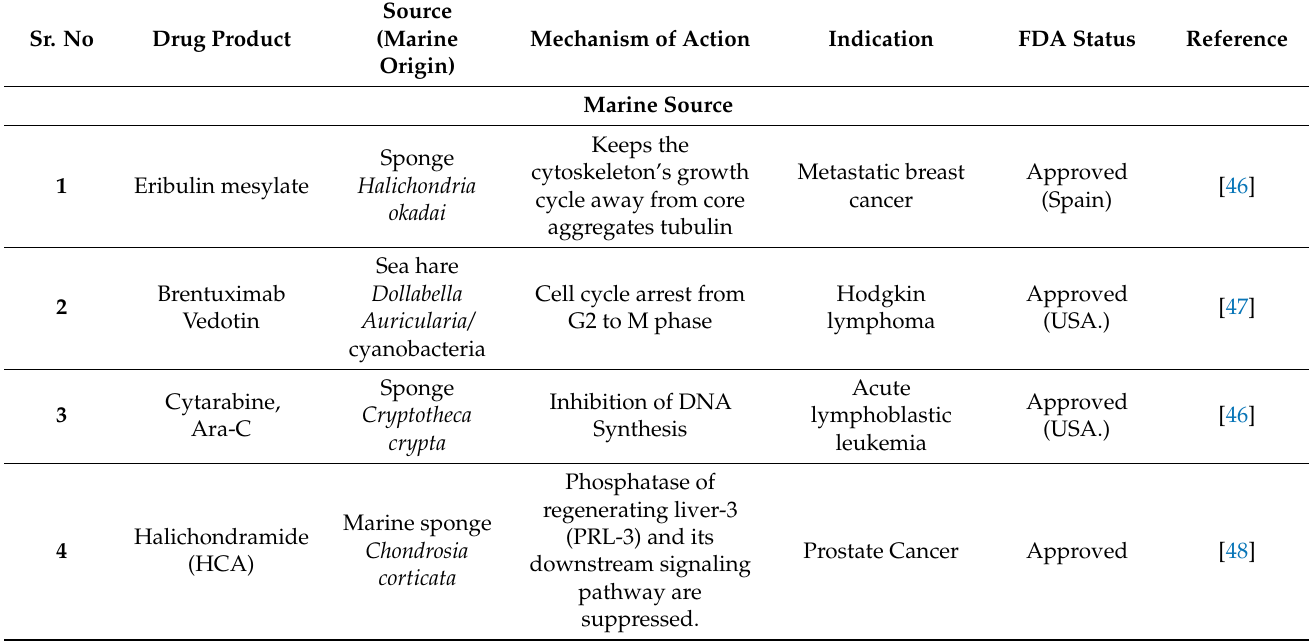
Table 1. Marine and plants-derived compounds for anti-cancer